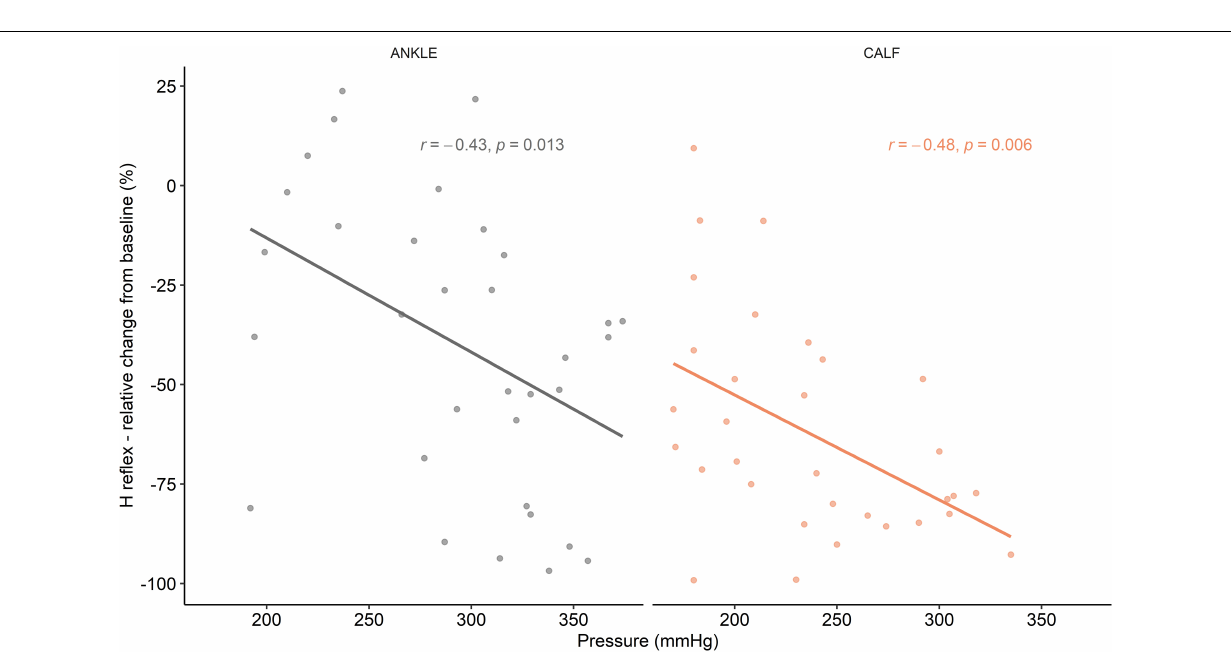
FIGURE 4 | Correlations between H reflex relative changes from baseline and flossing